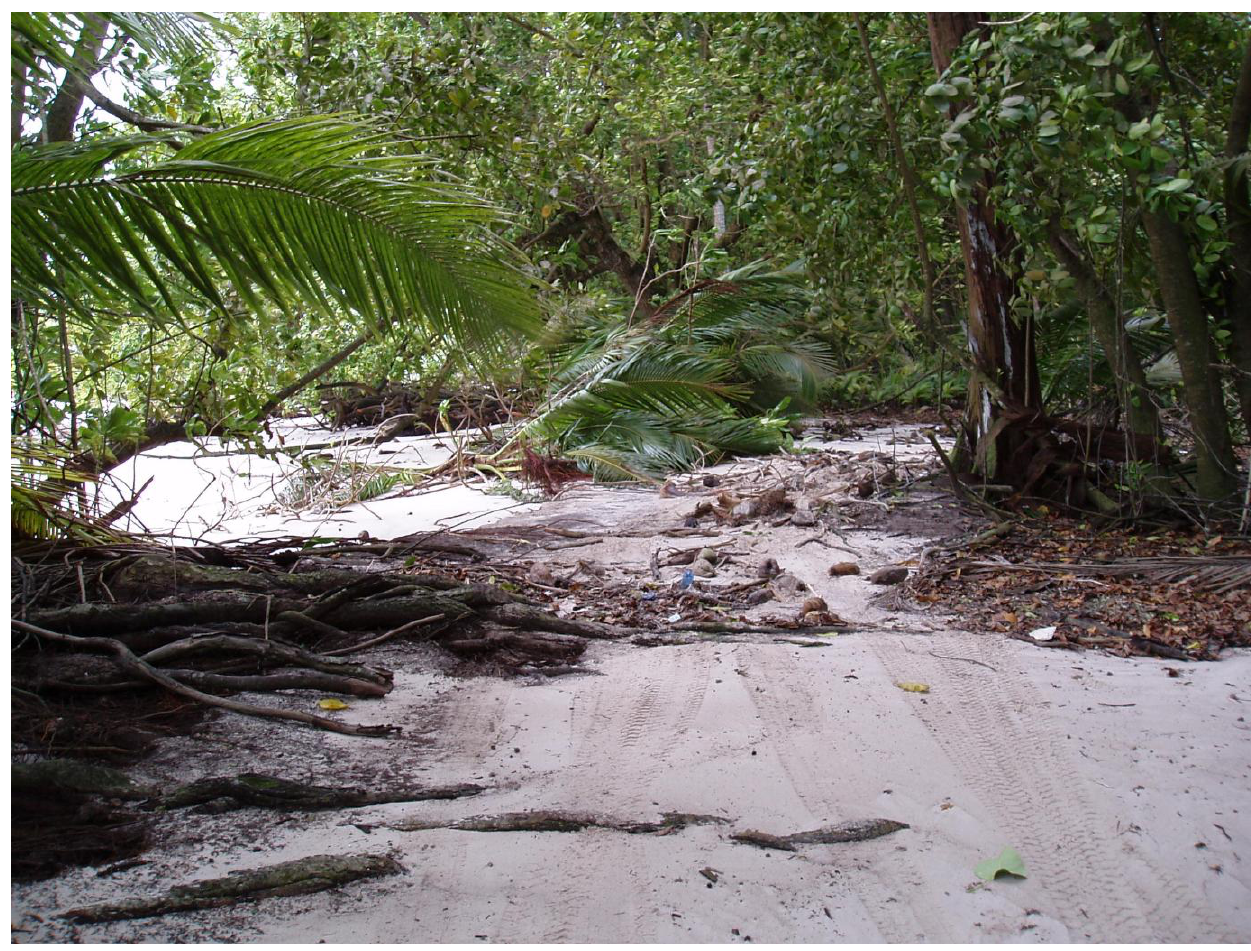
Figure 4. Sheltered, lagoon facing shore showing ingress of white sand onto the island. The raised ridge that mostly separates the beach from the interior of the island has disappeared along considerable lengths of the lagoon facing